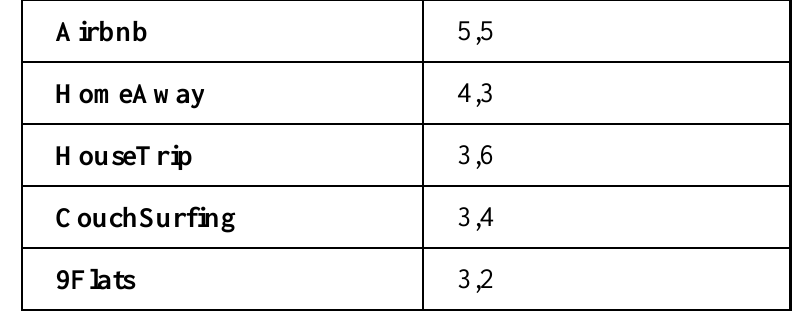
Table 4: Mean Value of Satisfaction for each Platform